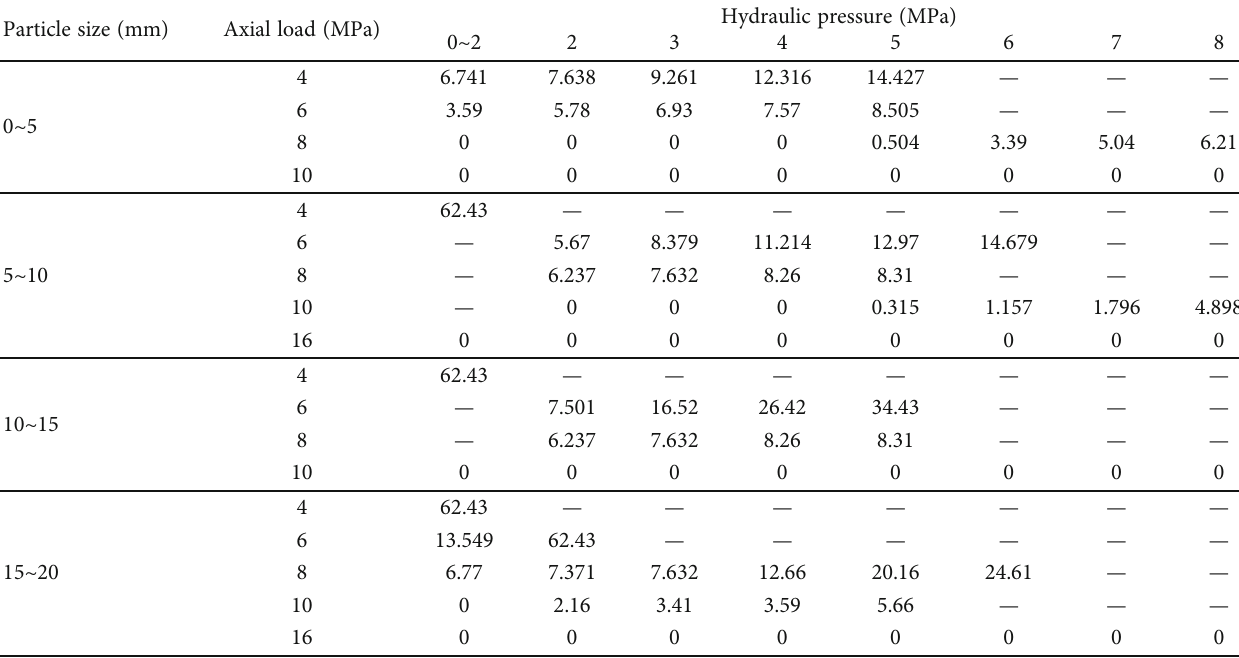
Table 5: Seepage discharges of di ff erent sizes of gangues.